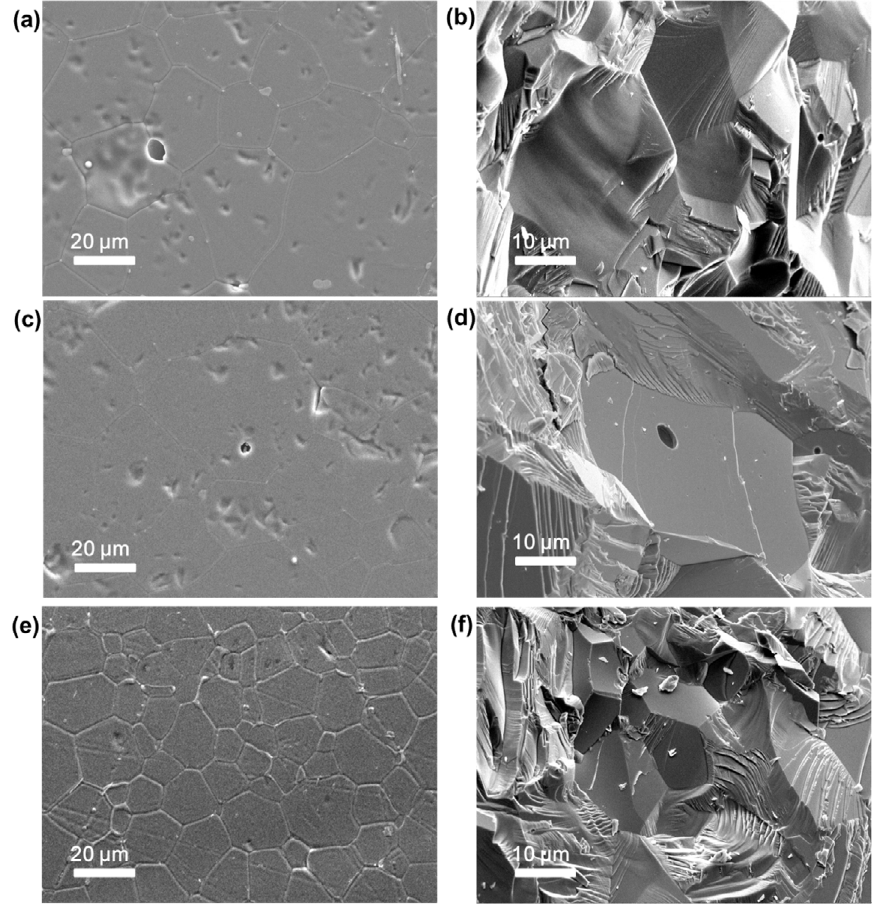
Fig. 2 Surface and fracture FESEM of (a, b) 5.0 at%, (c, d) 10.0 at%, and (e, f) 15.0 at% La-doped Y 2 O 3 ceramics at a sintering temperature of 1750 ℃ for 15